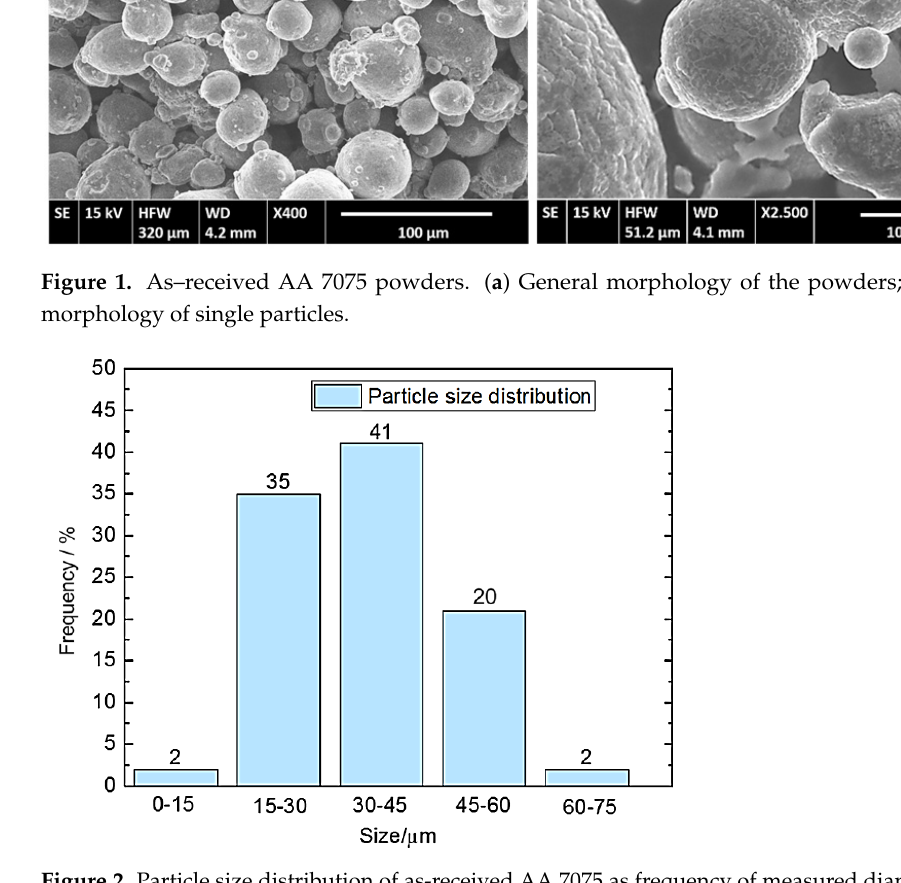
Figure 2. Particle size distribution of as-received AA 7075 as frequency of measured diameters in the defined ranges (µm).